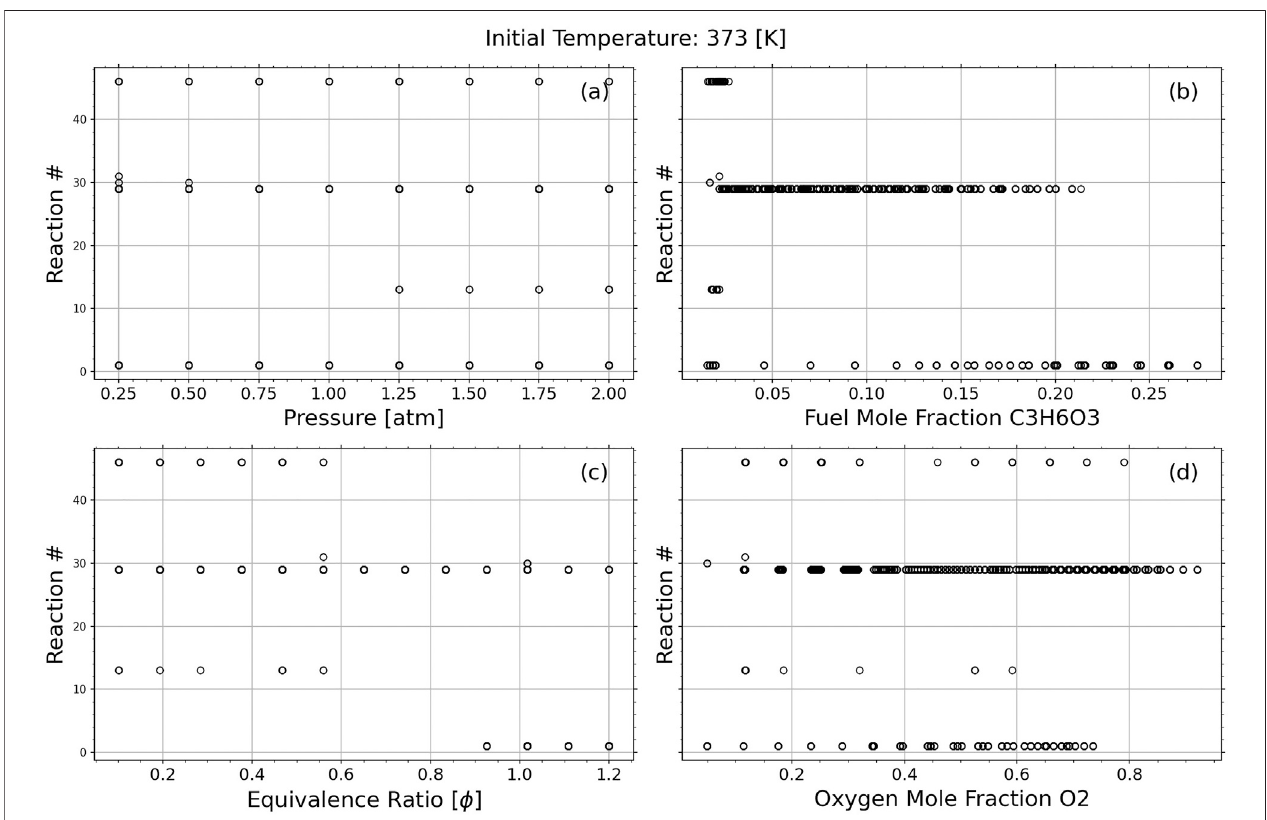
FIGURE 5 | Most sensitive reactions per parameter.